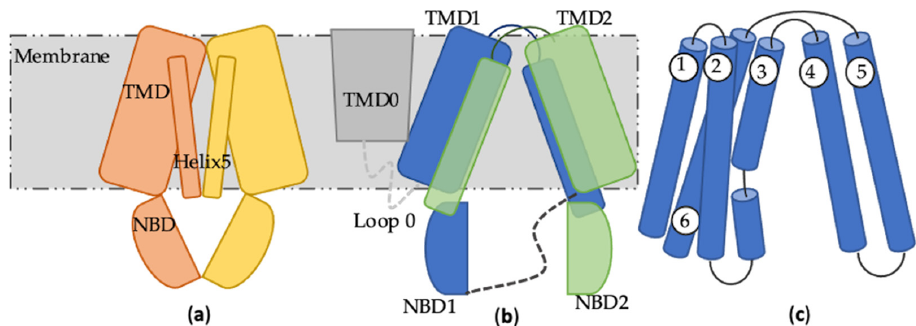
Figure 2. Inward facing apo conformation comparison of ABCG2 dimer with ABCB1 and ABCC1. ( a ) the two helices 5 from two ABCG2 subunits (one monomer in orange, another in yellow) rotate towards the central crevice, while the remaining helices of the NBD rotate towards the intracellular space. ( b ) ABCB1 and ABCC1 are full transporter with two TMDs and NBDs (TMD1 and NBD1 in blue, TMD2 and NBD2 in green), while the ABC1 comprises an extra TMD0 colored in grey connected by loop 0. ( c ) Topology diagram of TMD1 domain-swapping of full transporters with two helices (helix 4 and helix 5) cross-over the central axis.